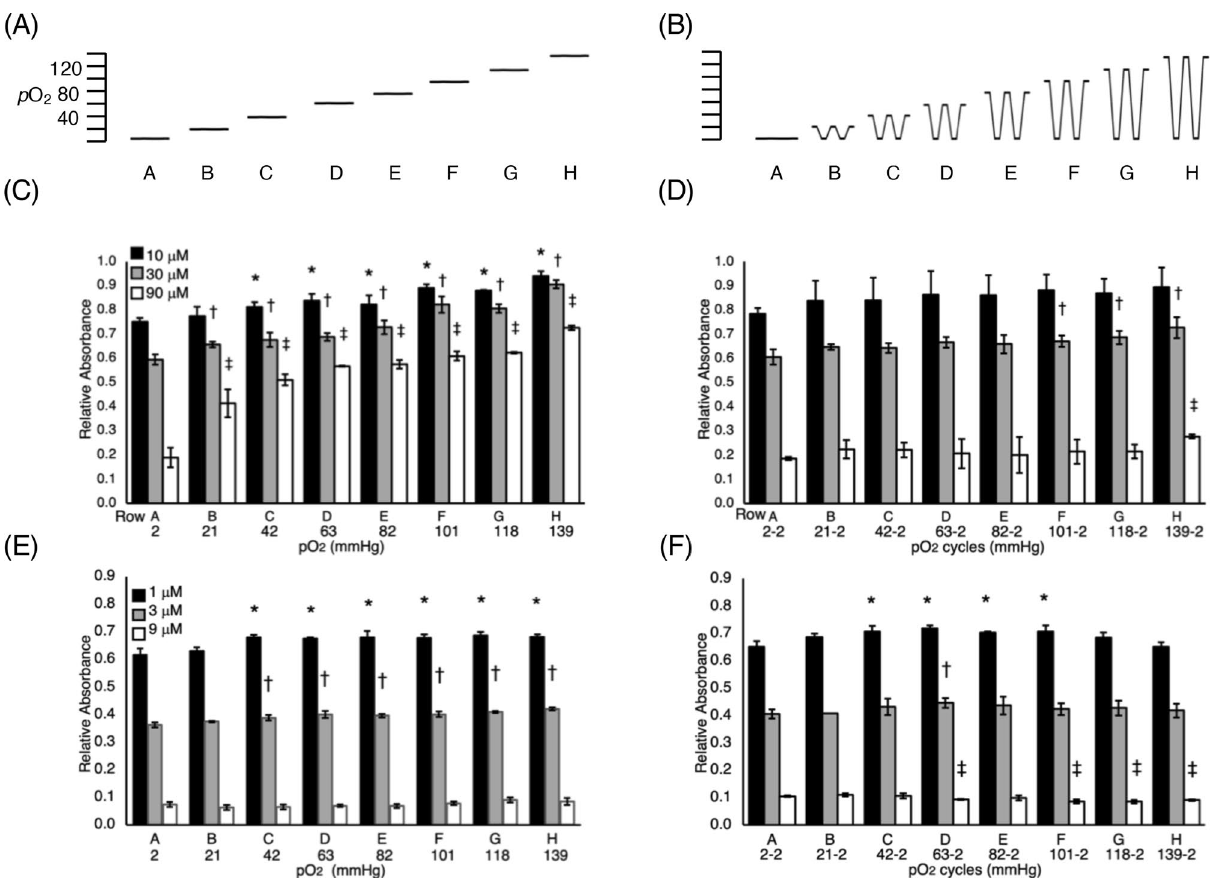
Figure 4. Drug dose response studies of PANC1 cells under ( A ) static p O 2 levels delivered to the lower channels for each row and ( B ) and cycling p O 2 levels with switching between p O 2 (hi) and p O 2 (lo) amplitudes indicated. ( C ) Dose response to tirapazamine under static and ( D ) cycling conditions. ( E ) Dose response to doxorubicin under static and ( F ) cycling conditions. *p < 0.05 relative to Row H at lowest dose; † p < 0.05 relative to Row H at middle dose; ‡ p < 0.05 relative to Row H at highest